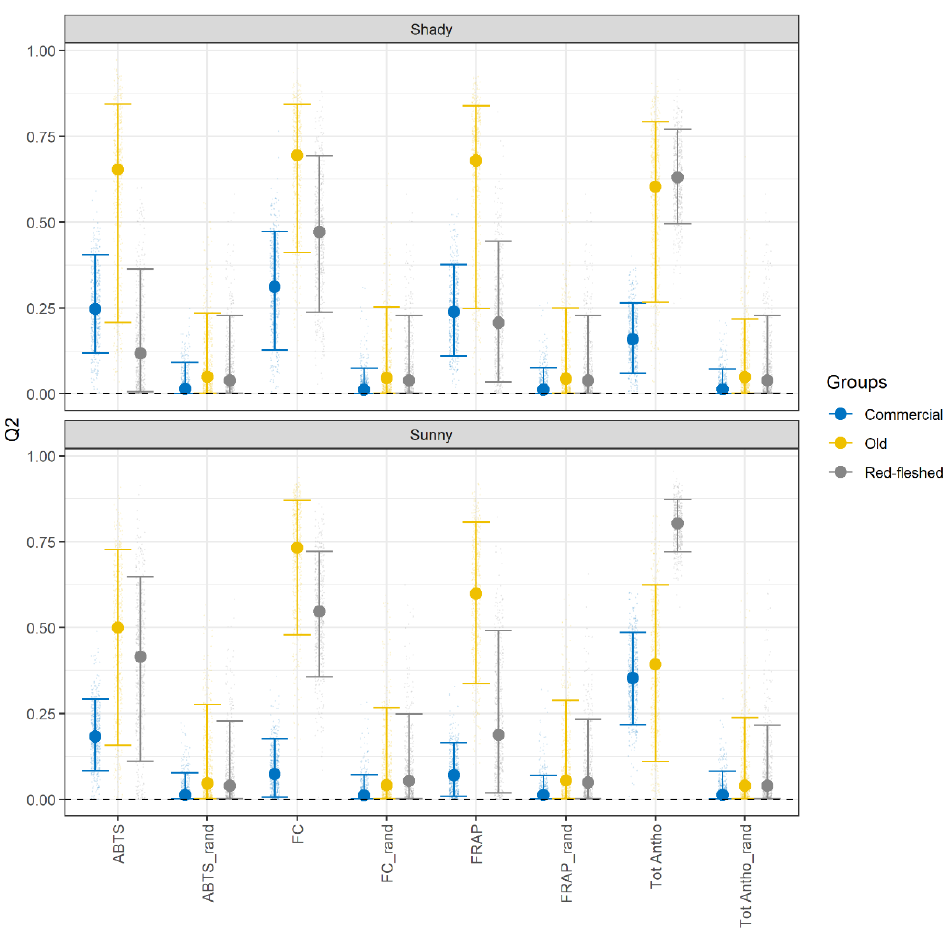
Figure 4. The quality of the PLS regression prediction model is measured by Q2 values using a 7-fold cross-validation (CV) repeated 10 times. The procedure of generating data, the splitting in train and test set, and fitting the models was set at 500 items. The points represent the median and the bars show the confidence intervals of 500 Q2 values. The confidence interval for the data is set at 99%.